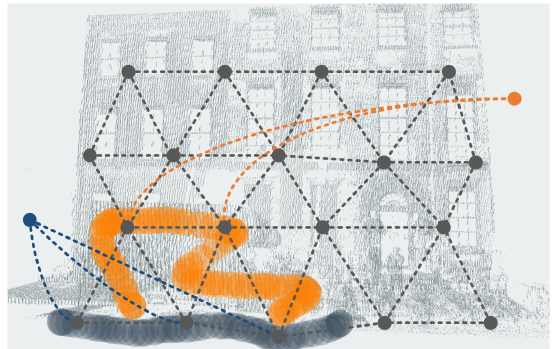
Figure 2: The orange and gray strokes are drawn by users to spec- ify the object (a van) and the background. Given the two strokes, a graph of the point cloud is built, the dots represent the nodes in the graph and the dashed lines are the edges. Noticeably, the blue and the orange dots are two added nodes as source and sink (see Figure 1), and the edges connecting them and common nodes (black) are also colored as orange and blue lines respectively.